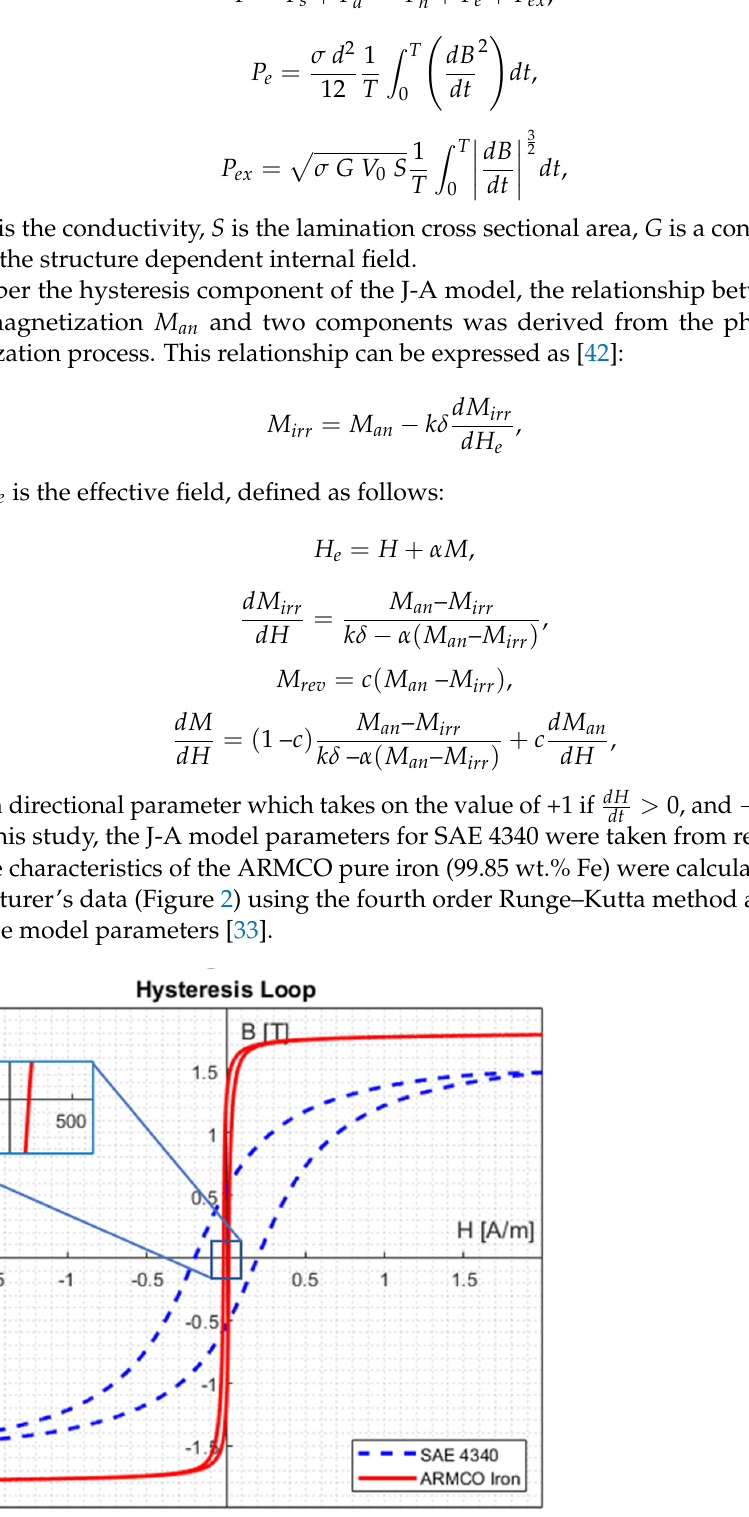
Figure 2. Hysteresis loops of the SAE 4340 steel and ARMCO pure iron. The inset shows a mag- nifcation of the loop at the origin.